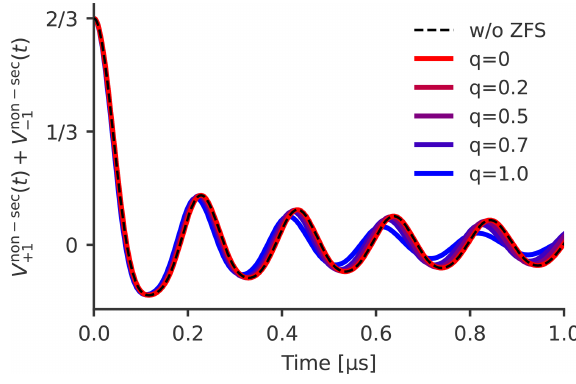
( t ) and V non-sec − ( t ) for different Figure 7. The sum of V non-sec + 1 1 values of q and P x = 0 . 33, P y = 0 . 41, P z = 0 . 26 and r = 2 . 2nm. Only the real part is shown. Table 1. The background decay values and modulation depths that were determined for the simulations from Fig. 8. The modulation depth for the simulations was always set to λ =